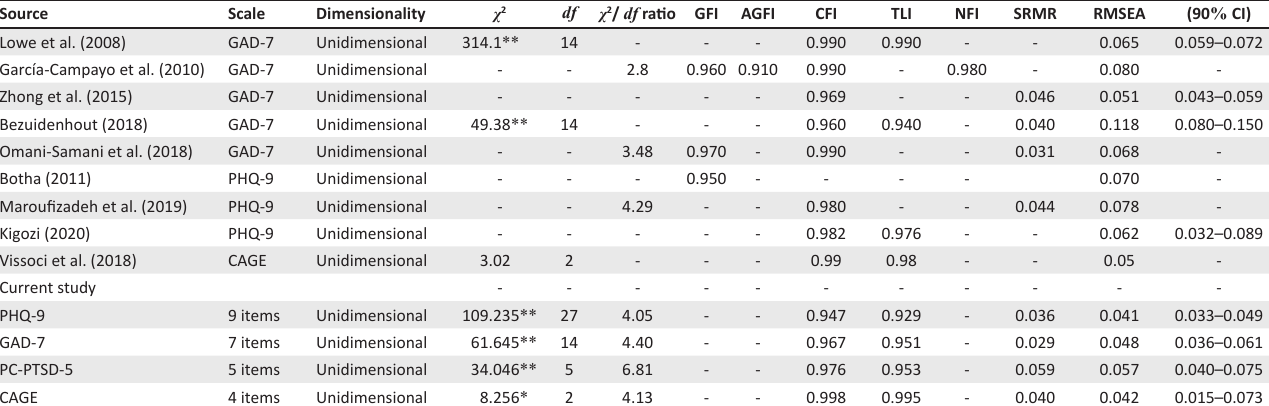
TABLE 3: Overview of fit indices for determining dimensionality of study